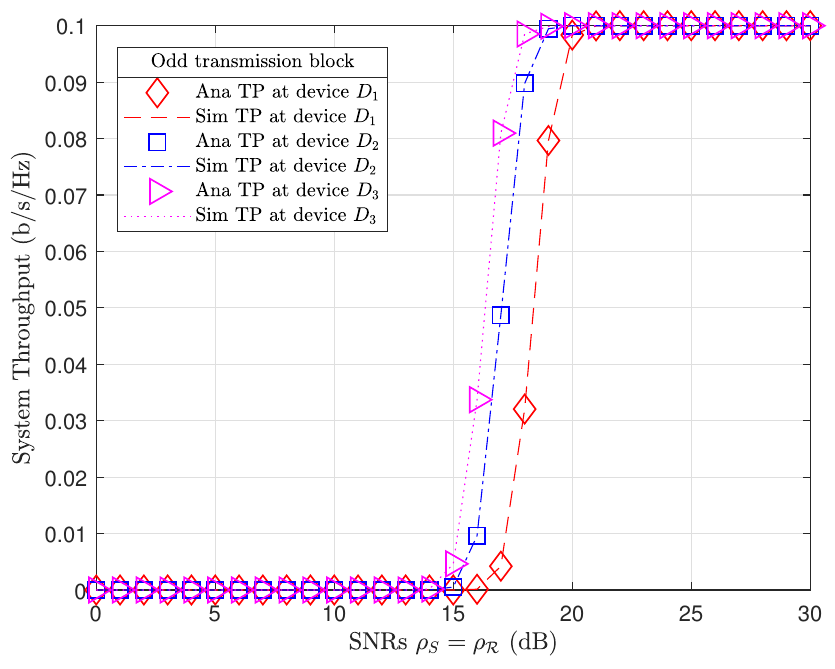
Figure 5. System throughput in odd transmission